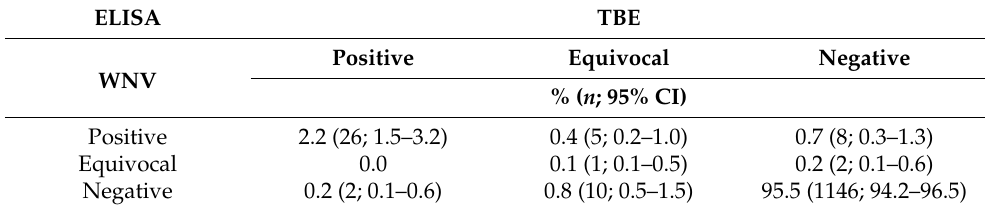
Table 2. IgG ELISA results for WNV and TBEV.